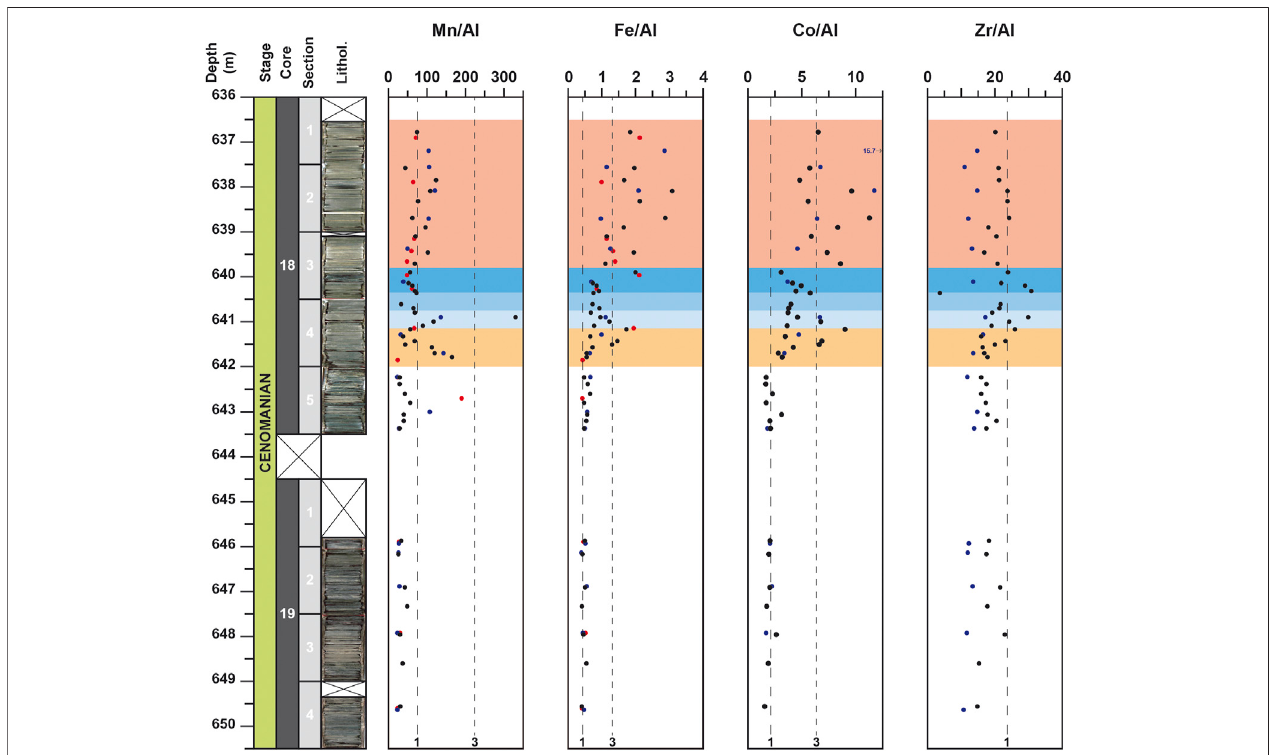
FIGURE6| Depth-pro fi lesforMn/Al,Fe/Al,Co/AlandZr/AlfortheDSDPsite367.DatafromthestudiesofKuypersetal.(2002),coupledtounpublisheddatafrom H-J. Brumsack on the same samples, and Westermann et al. (2014) are represented with blue and red circles respectively. Vertical black dotted lines, noted 1 and 3, representthe El/Alvaluecorrespondingtoan EF equalto 1and 3, respectivelycomparedtothe Upper Continental Crust (McLennan,2001):0.75 for Mn/Al; 0.44for Fe/ Al; 2.11 for Co/Al and 23.63 for Zr/Al.